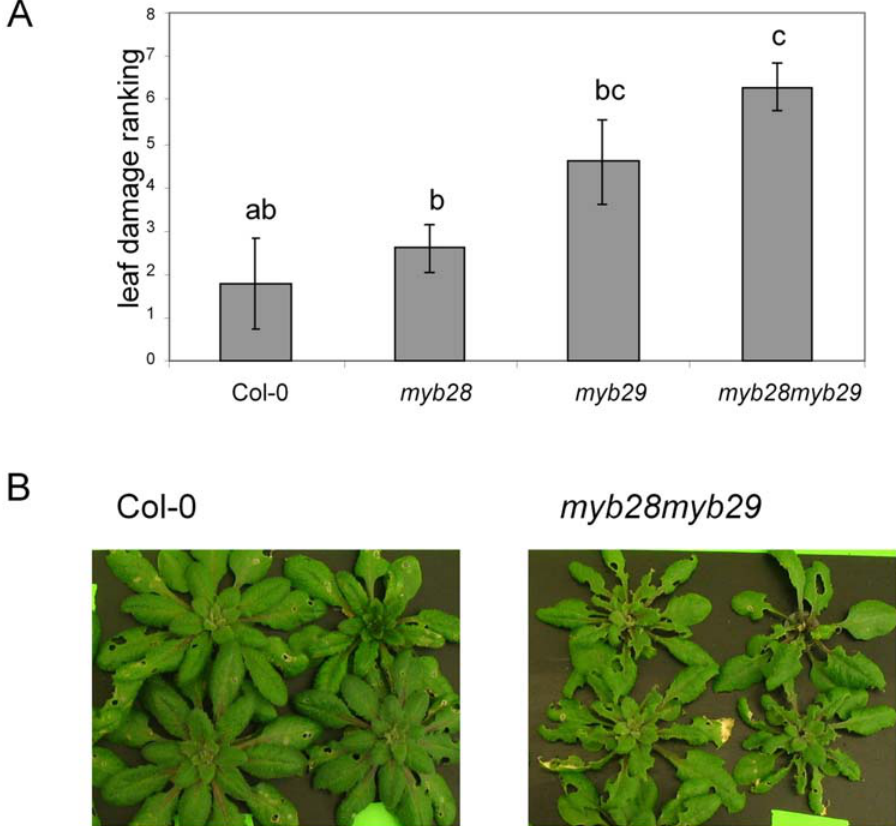
Figure 8. Plant damage after 10 days of Mamestra feeding. (A) Ranking by five observers from 1 (lowest damage) to 7 (highest damage). Different characters over the bars indicate significant differences between the treatments after Kruskal-Wallis ANOVA followed by Multiple Comparison analysis (2-tailed). (B) Pictures of representative plants of wild type Col-0 and myb28myb29 on day 10 of Mamestra feeding.